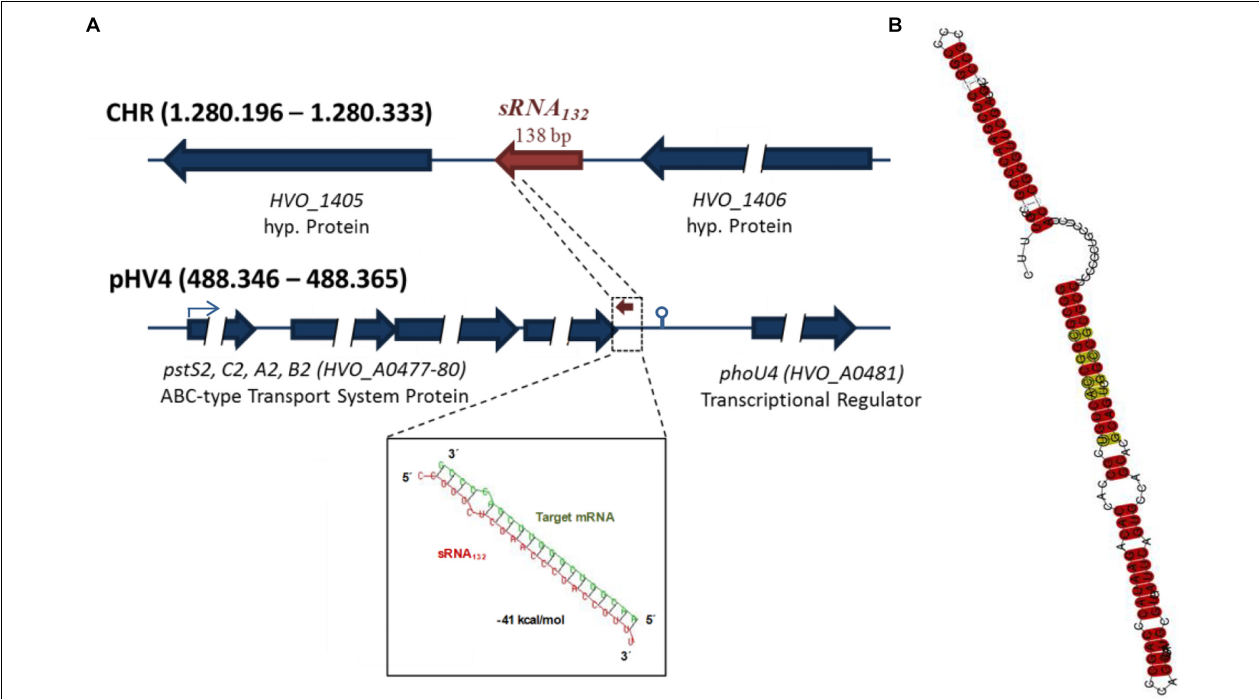
FIGURE 1 | Features of sRNA132. (A) Genomic localizations of the sRNA132 gene and the operon of its putative target mRNA. HVO numbers are designations of genes in the H. volcanii genome. The predicted interaction between sRNA132 and the 3 (cid:48) -UTR of its target mRNA is shown at the bottom. (B) Predicted secondary structure of sRNA132. The prediction is based on a multiple sequence alignment ( Supplementary Figure S1B ). The degree of conservation is color-coded, highly conserved positions are shown in red.